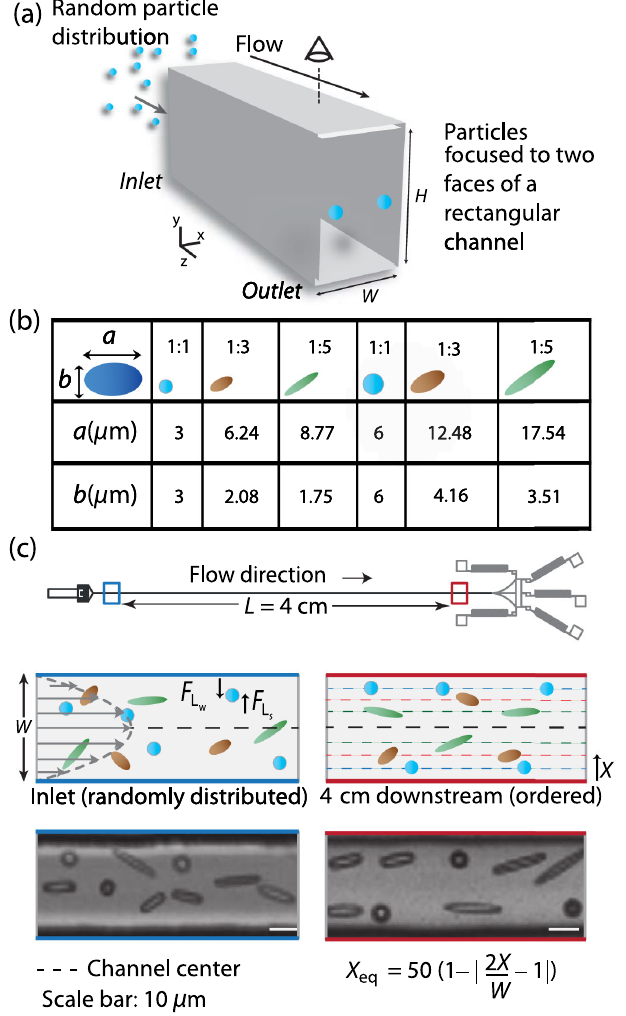
FIG. 1. Focusing of ellipsoids of different aspect ratios to two sets of dynamic equilibrium positions. (a) In rectangular chan- nels with a high aspect ratio, at moderate Re , randomly distrib- uted particles are known to focus to two equilibrium regions centered at the long faces of the channels. (b) The particle shapes, stretching ratios, and ellipsoid dimensions evaluated in the current work. (c) The microfluidic device (upper drawing) used for shape-based separation consists of a simple straight 4-cm long channel, with W ¼ 25 , 30, or 35 (cid:1) m , and H ¼ 47 (cid:1) m . At the inlet (middle drawing, left), particles are initially ran- domly distributed within the fluid. Equilibrium positions ( X ) eq are measured at the channel outlet (middle drawing, right), 4 cm downstream of the inlet, where particles are assumed to be inertially focused due to the combined effect of F (wall-effect L w lift) and F (shear-gradient lift). Overlaid pictures (scale bar ¼ L s 10 (cid:1) m ) illustrate particle distribution, respectively, at the inlet (right) and outlet (left). The lower images are multiple overlays of frames captured at the channel inlet (left) and outlet